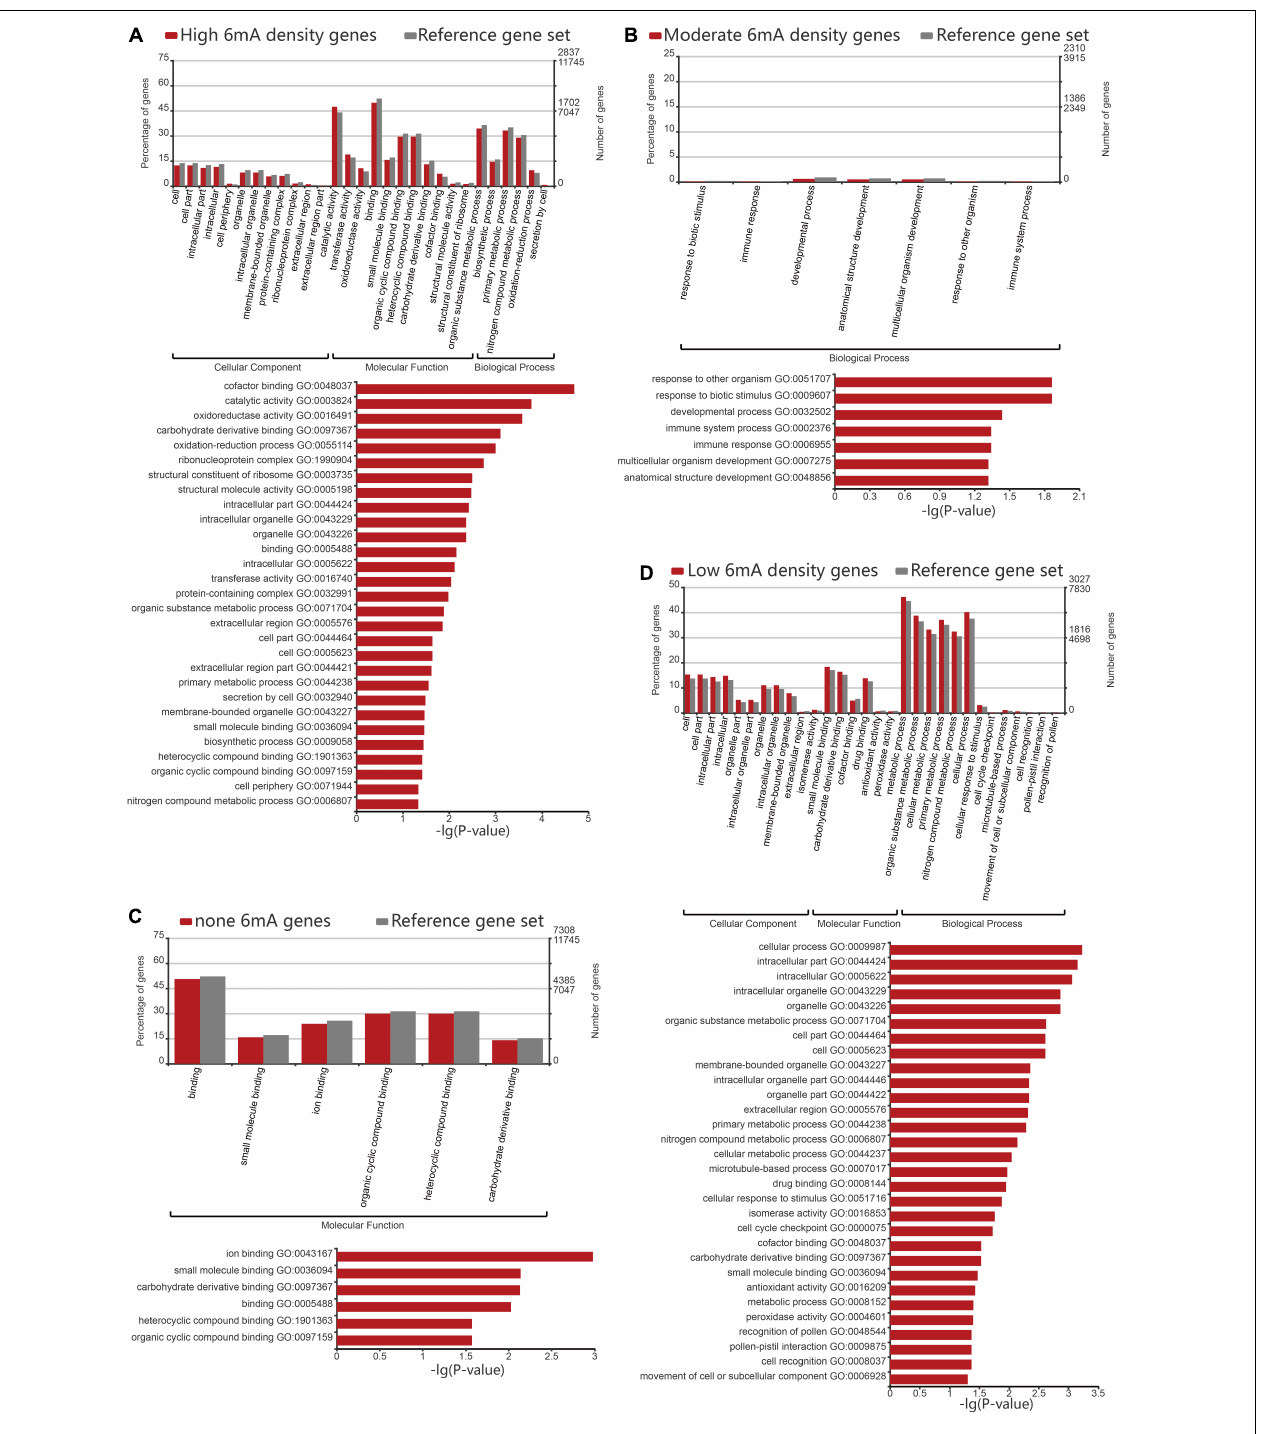
FIGURE 4 | Gene ontology analysis of different 6mA methylation levels genes. (A) Gene ontology analysis of high density 6mA genes. (B) Gene ontology analysis of medium density 6mA genes. (C) Gene ontology analysis of non-6mA-modified genes. (D) Gene ontology analysis of low density 6mA genes.